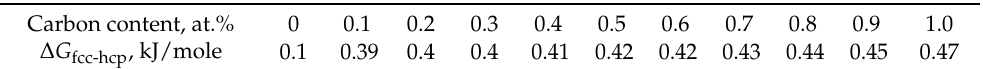
Table 4. ∆ G fcc-hcp values obtained for the Fe 50 − x Mn 30 Co 10 Cr 10 C x ( x = 0–1 at.%) high entropy alloys using the ThermoCalc software. Carbon content, at.%